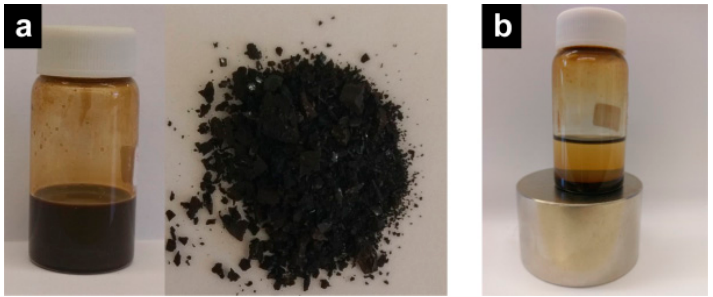
Figure 9. ( a ) MNPs-IL-C 4 @PU NCs as suspension and powder and ( b ) a magnetic separation of MNPs- MNPs-IL-C 4 @PU IL-C 4 @PU NCs.